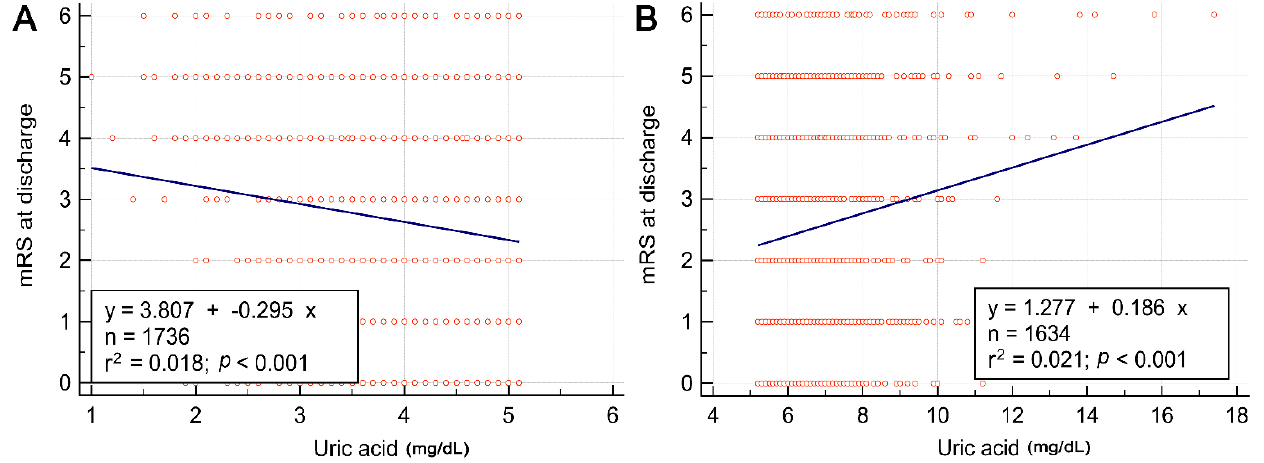
Figure 2. Linear correlation between uric acid and modified Rankin Scale score in patients within Quartiles 1 and 2 of uric acid ( A ) and in patients within Quartiles 3 and 4 of uric acid ( B ). mRS, modified Rankin Scale.